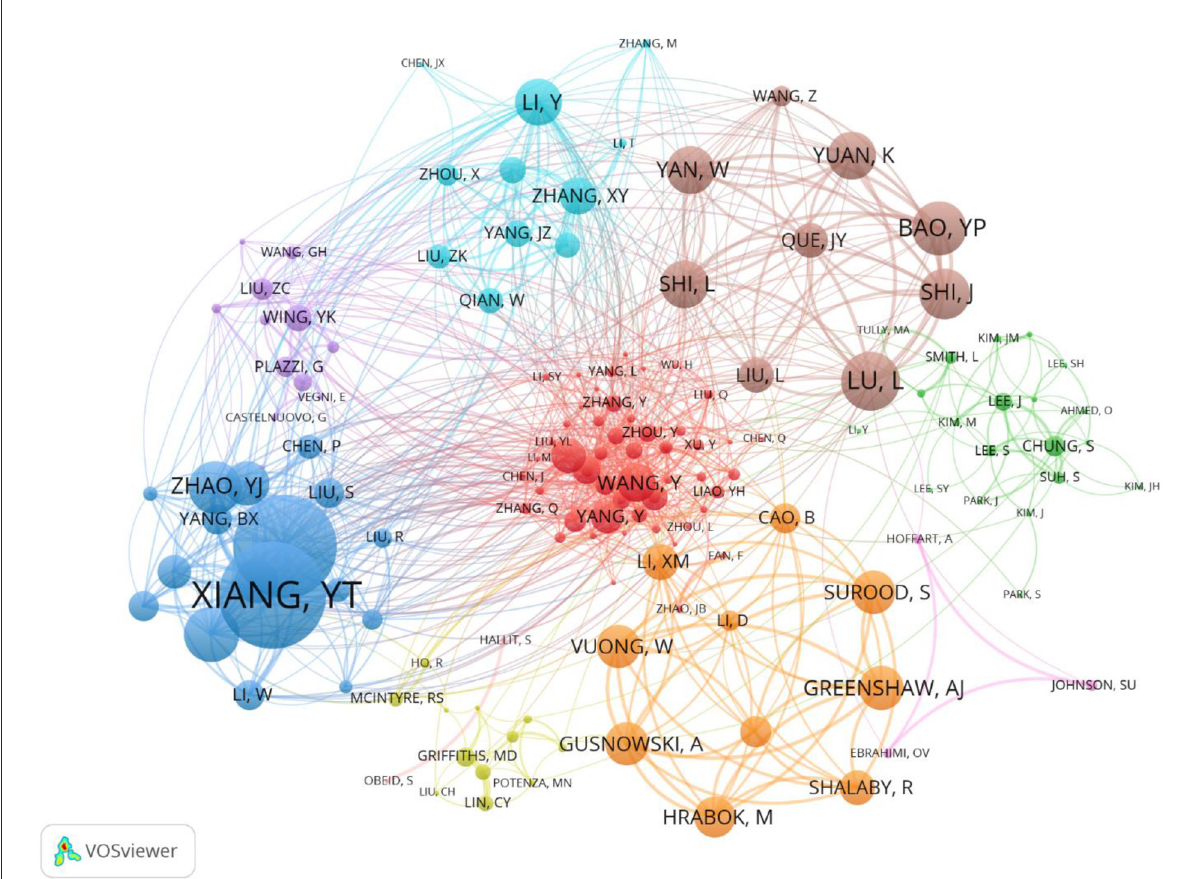
FIGURE7 Map of co-authors network. The nodes represent authors. Node size indicates the number of articles produced. The lines represent cooperation